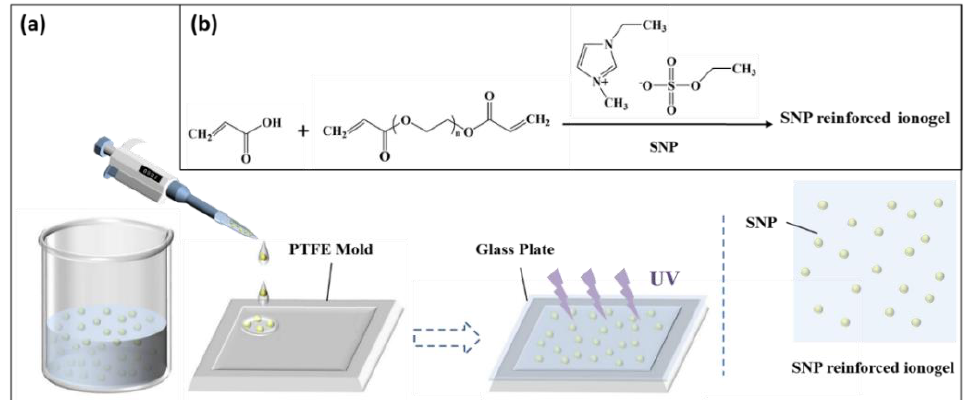
Figure 1. Preparation process of silica nanoparticle (SNP)-reinforced ionogel: ( a ) material preparation and ( b ) chemical reaction process of SNP-reinforced ionogel.